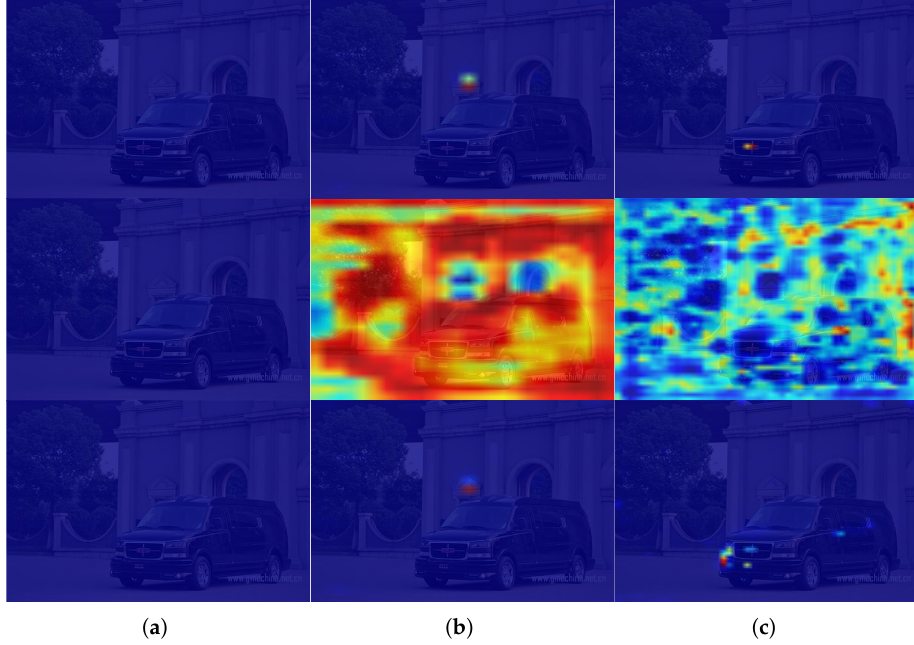
Figure 10. Comparison of heatmaps of YOLOv4 output layers: ( a ) 13 * 13 output layer; ( b ) 26 * 26 output layer; ( c ) 52 * 52 output layer.